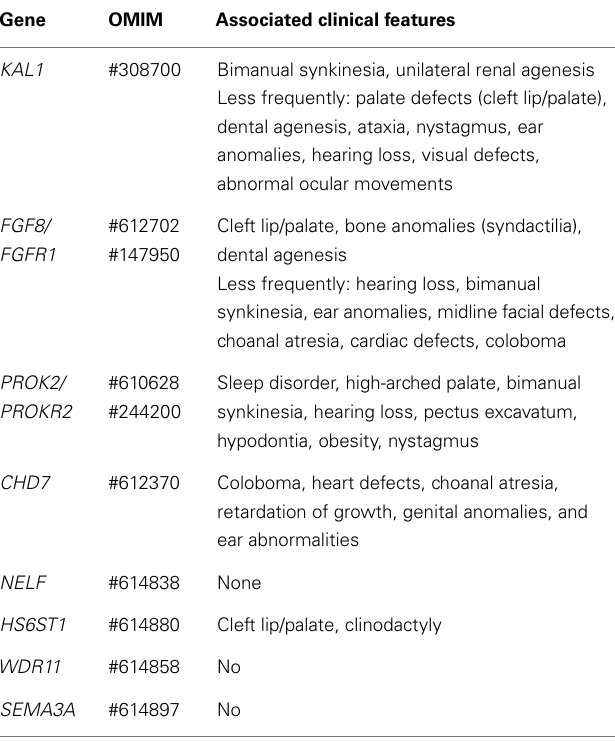
Table 5 |Associated clinical features in male patients with fetal-onset isolated central hypogonadism due to defects in the migration of the GnRH